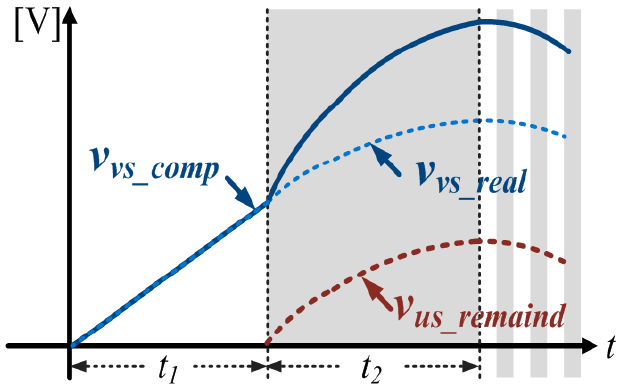
Figure 10. One-quarter of the V phase command voltage of the proposed neutral-point voltage-shifting control.